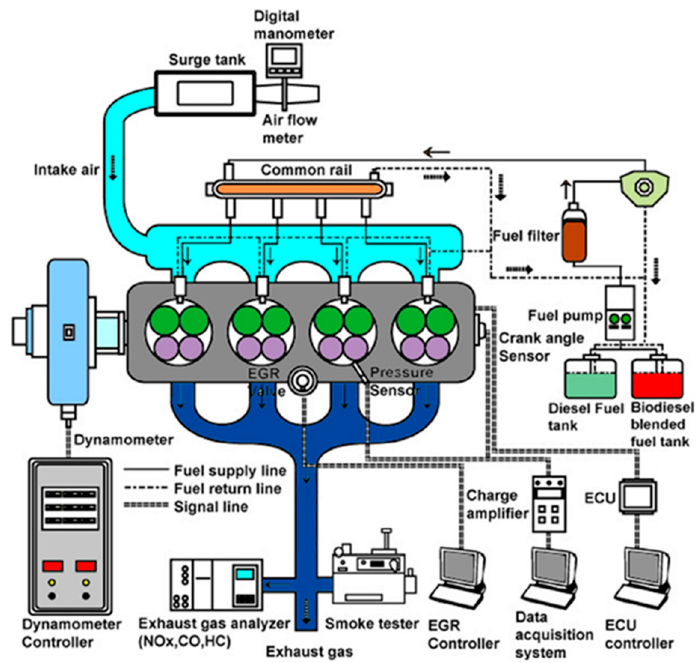
Figure 2. Schematic of the inline experimental equipment. 163